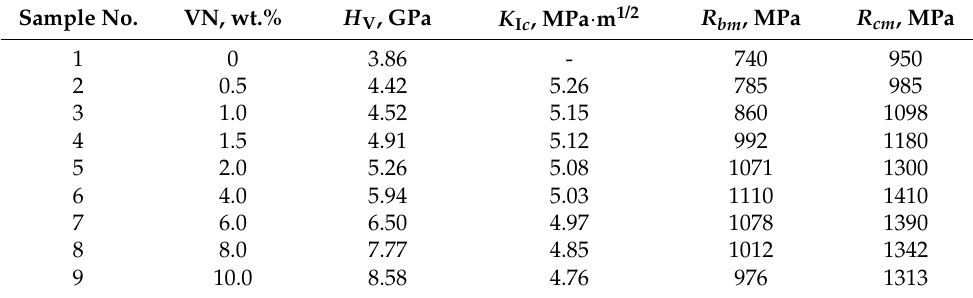
Table 3. Mechanical characteristics of sintered samples with different VN content. Sample No.